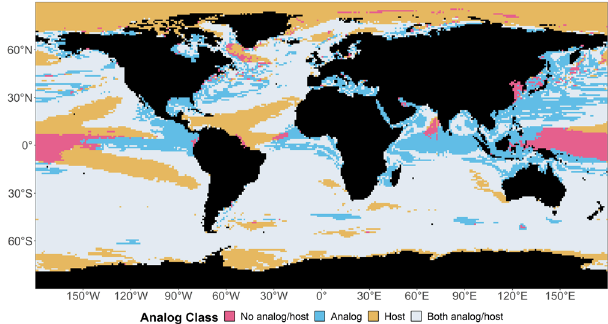
Fig. 1 Global marine map showing pixel classi fi cation based on thermal analogous conditions. Pixels are grouped in four classes: (i) will not have a thermal analog and will not host past thermal conditions in the future (red); (ii) will have a thermal analog, but will not host past thermal conditions in the future (blue); (iii) will not have a thermal analog, but will host past thermal conditions in the future (orange); and (iv) will have a thermal analog and will host past thermal conditions in the future (white). Black pixels represent land mass, water masses that are blocked by land mass, and pixels with no climatic